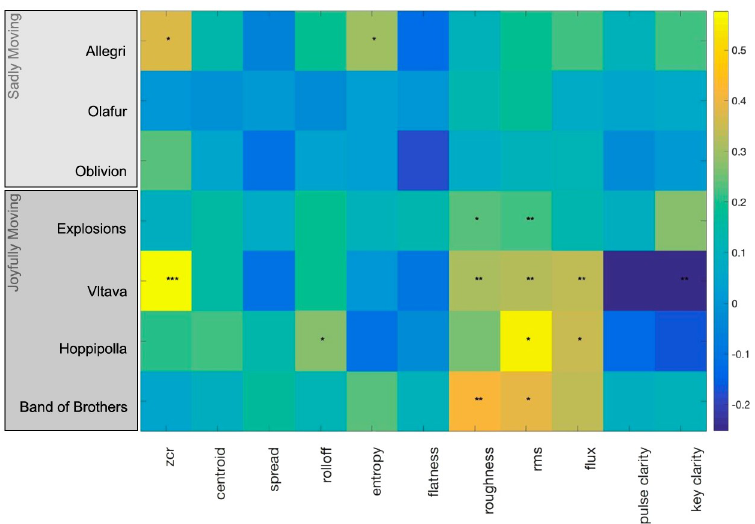
Fig 6. A visualization of the spearman correlations between continuous ratings of feeling moved or touched , and the acoustic and musical features of the music excerpts. Color gradients represent the strength of the correlation coefficient. � p < .05, �� p < .01, ��� p <